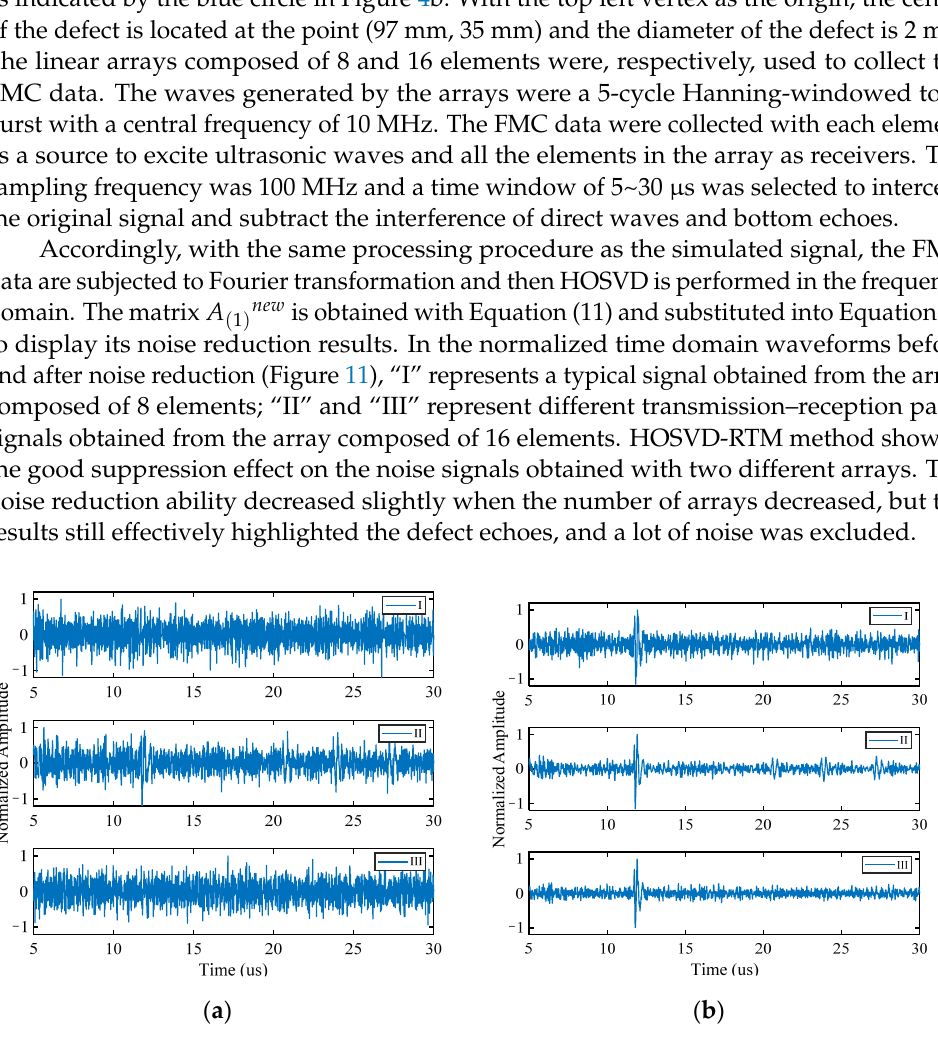
Figure 11. Time domain waveforms of experimental signal ( a ) before noise reduction; ( b ) after noise reduction.